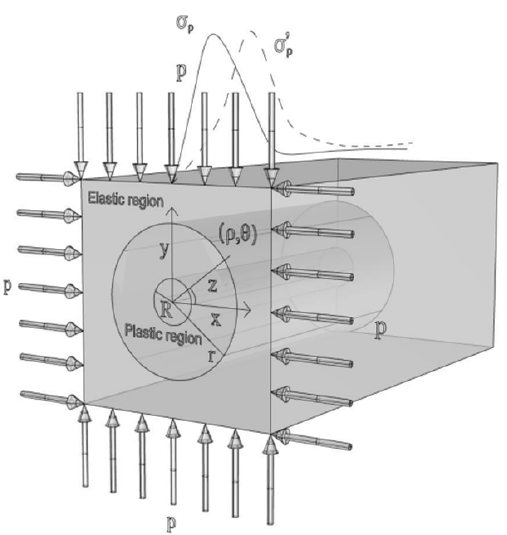
Figure 14. Schematic diagram of borehole mechanics model of roadway surrounding rock.